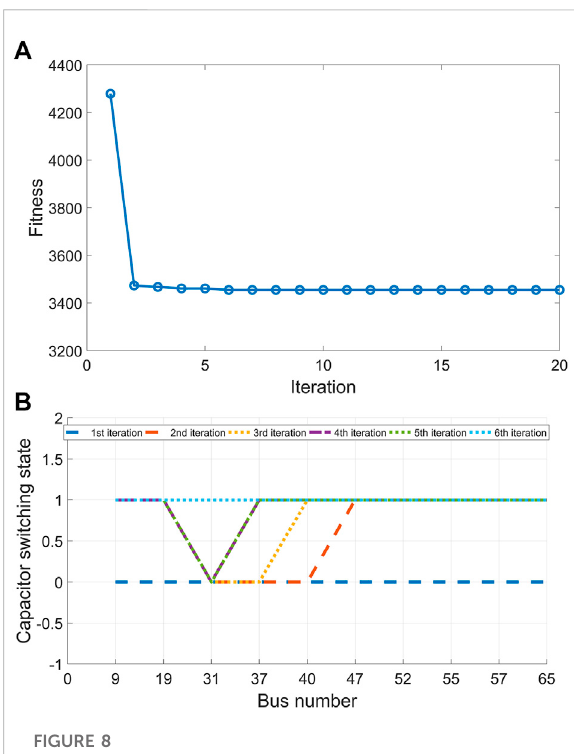
FIGURE 8 The evolution pro fi les of fi tness and switching state of